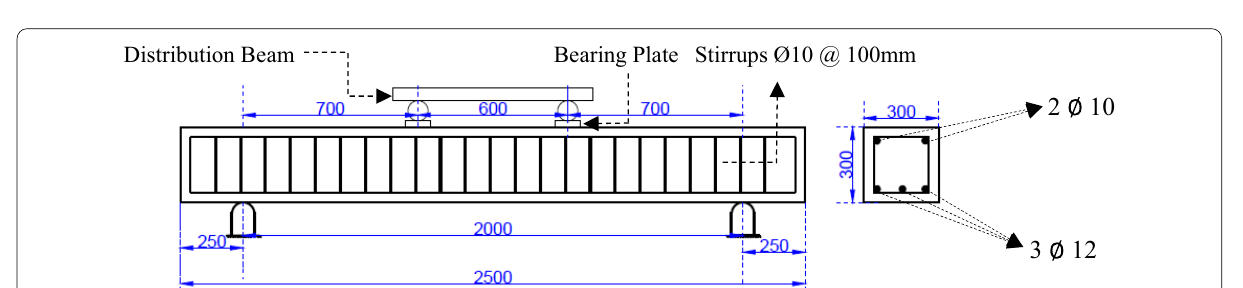
Fig. 2 Details of the reference beam (dimensions in